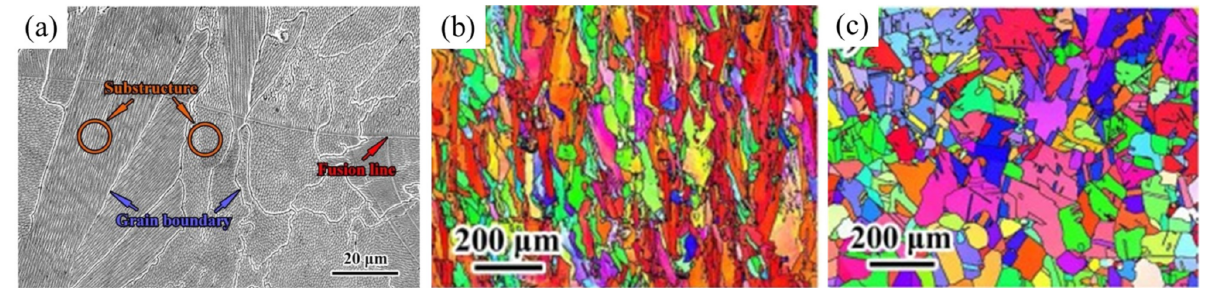
Figure 11. ( a ) SEM images of SLM-built CoCrFeNi HEA showing its cellular structure; EBSD of CoCrFeNi HEA in ( b ) as- built and ( c ) annealed conditions, confirming columnar microstructure for as-built and equiaxed for annealed sample. Reprinted with permission from ref. [355]. Copyright 2021